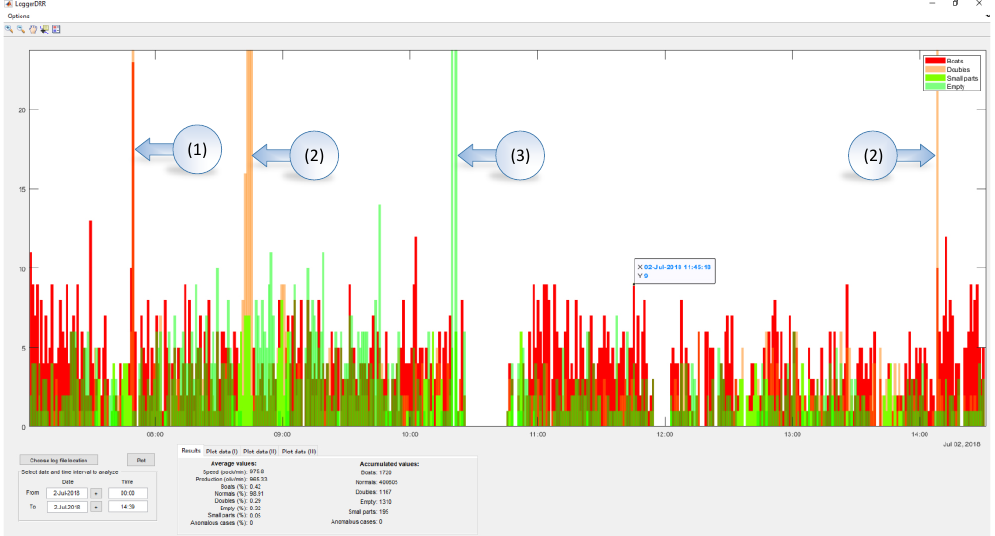
Figure 19. Instantaneous values for boats, doubles, small parts and empty.